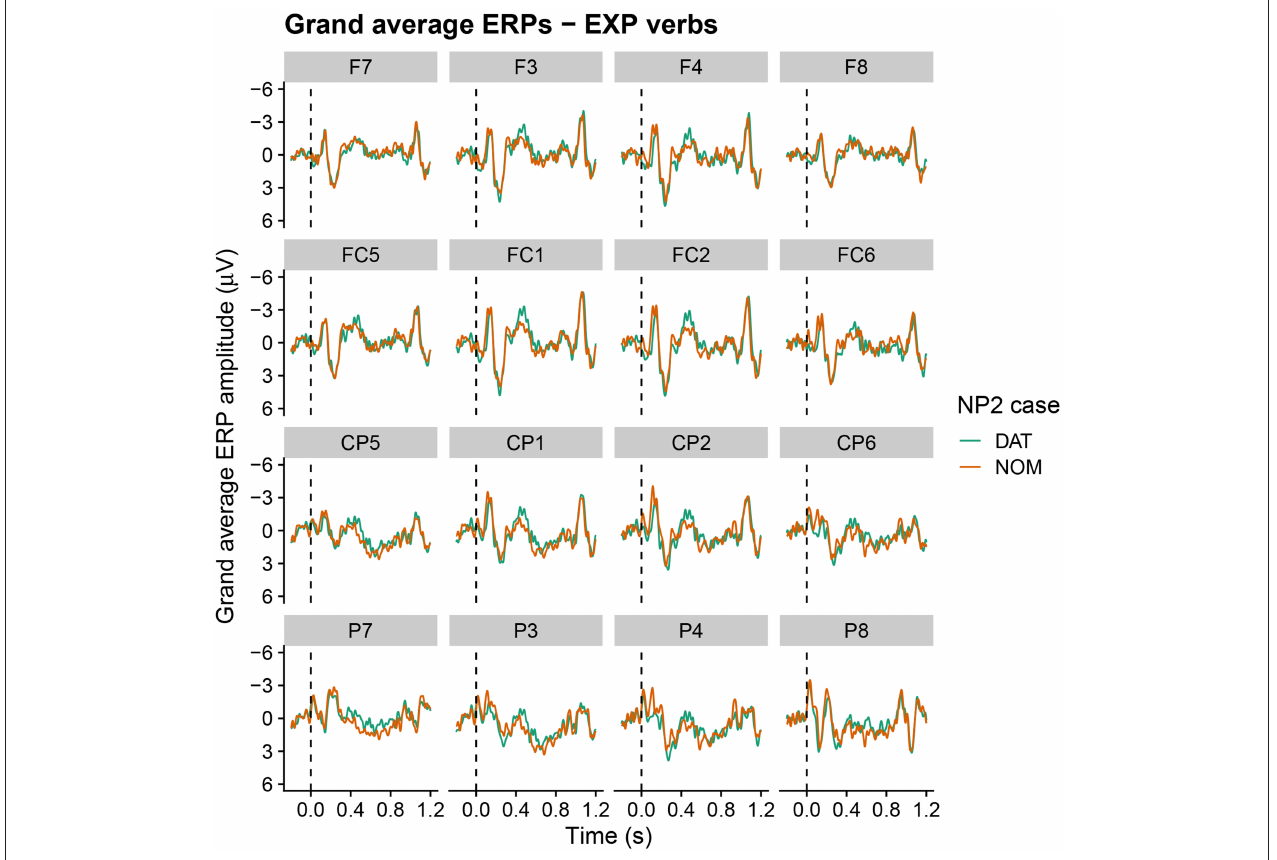
FIGURE 5 | Grand average ERPs at the critical NP2 position for sentences with experiencer verbs (onset at the dashed vertical line). Negativity is plotted